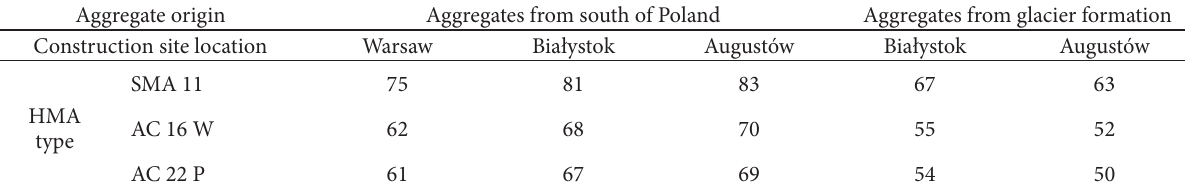
Table 4. Comparison of the HMA mixture cost for various locations and aggregate types Aggregate